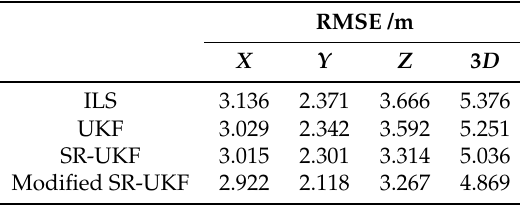
Table 4. Position estimation error using GPS’s data.